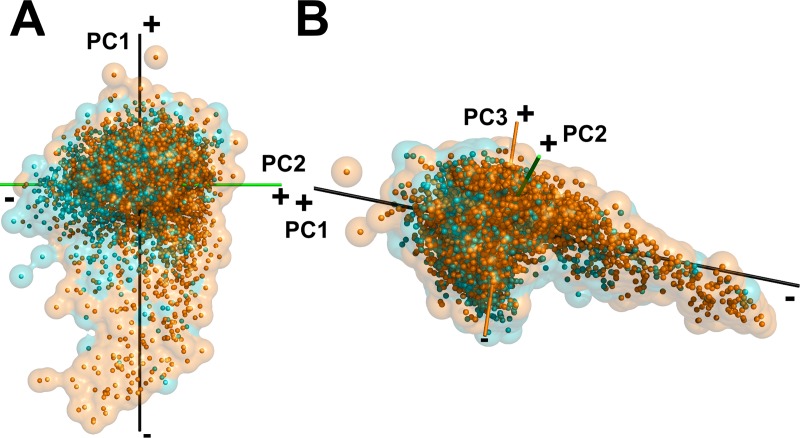
The distribution of monomers and complex forming proteins.(A), the distribution is shown on the 1–2 plane, same as the orientation in panel D in Fig 1. (B), the distribution is shown in the same orientation as panel B in Fig 1. Cyan, monomers; orange, complex-forming proteins.